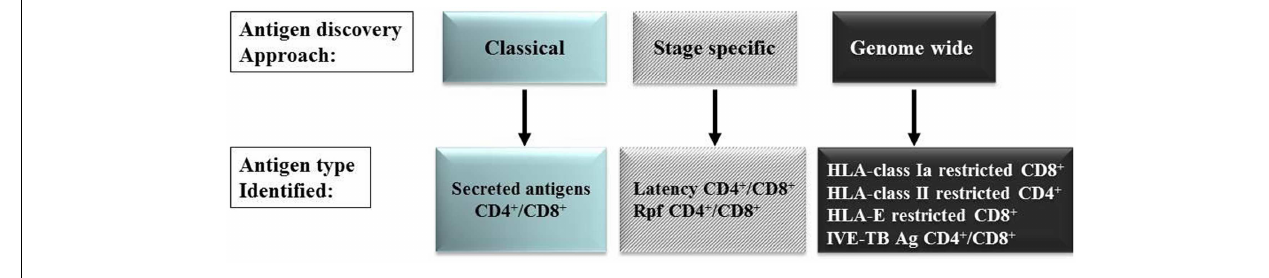
FIGURE 1 | Mtb antigen discovery approaches